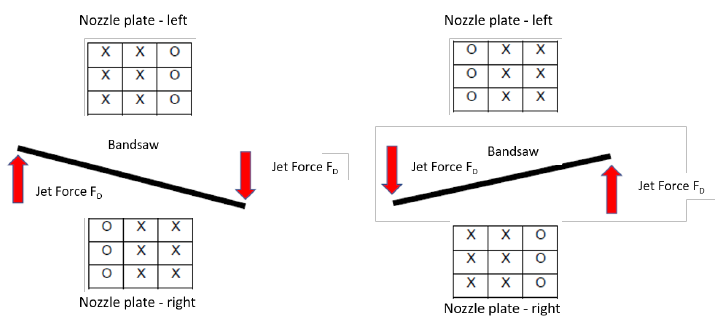
Figure 11. Nozzle plate configuration for band deflection towards the plate being cut ( left ) and towards the remaining stone block ( right ), whereby 0: open nozzle; X: closed nozzle.